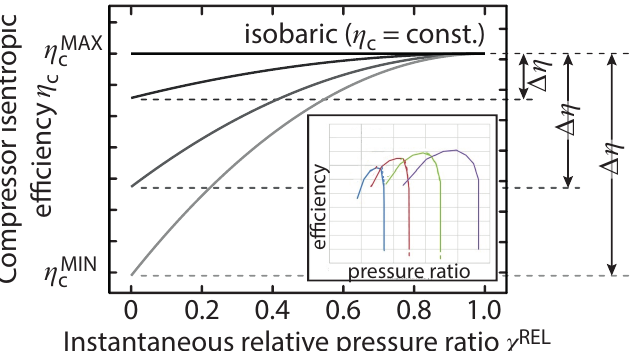
Figure 3. Illustrating the compressor off-design performance with three arbitrary differences between on-design and off-design isentropic efficiency. The inset illustrates a path on a real compressor map (adapted from [13]), whose increasing efficiency portion we model as a second degree